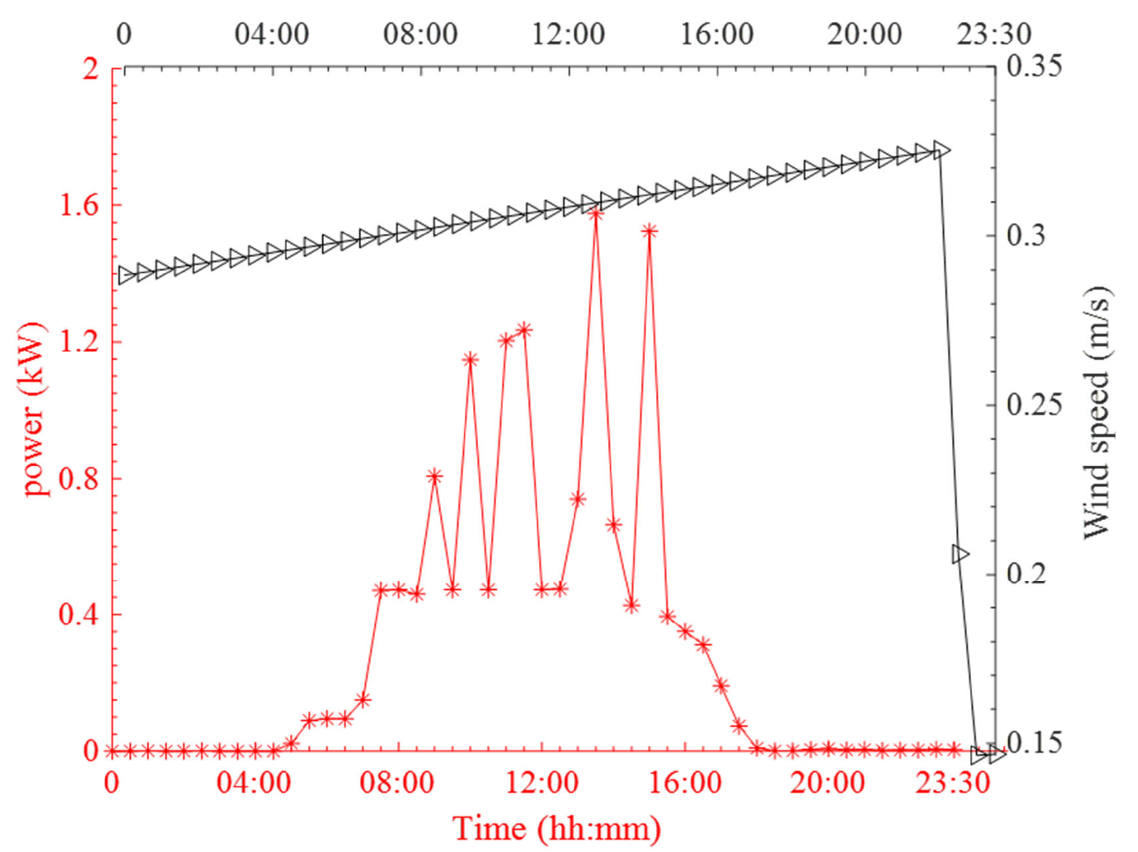
Figure 10. Average weekday profiles of power consumed and wind speed. (kW denotes kilo Watt, % represents percentage, hh denotes hour and mm denotes minute).